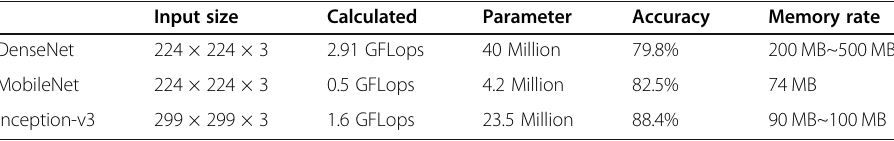
Table 7 Comparison of the accuracies and complexities of the three models Input size